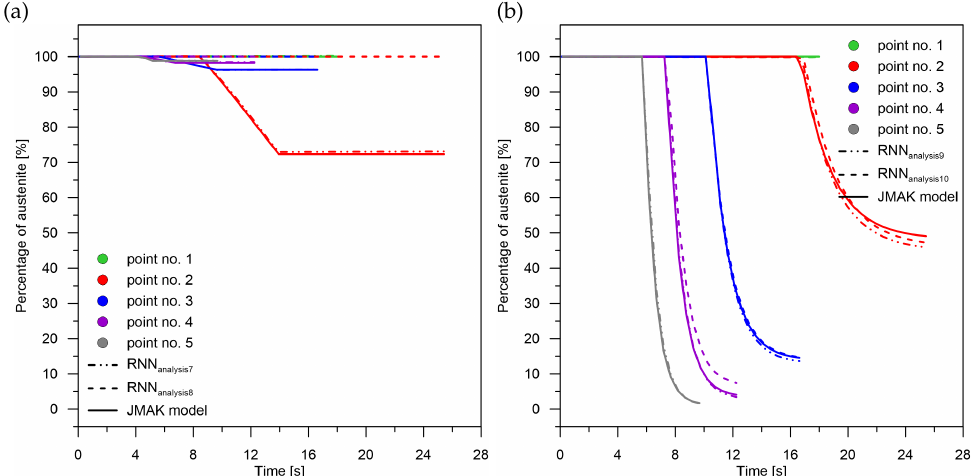
Figure 12. Analysis of phase transformation kinetics. ( a ) Analysis No. 7 and No. 8. ( b ) Analysis No. 9 and No.